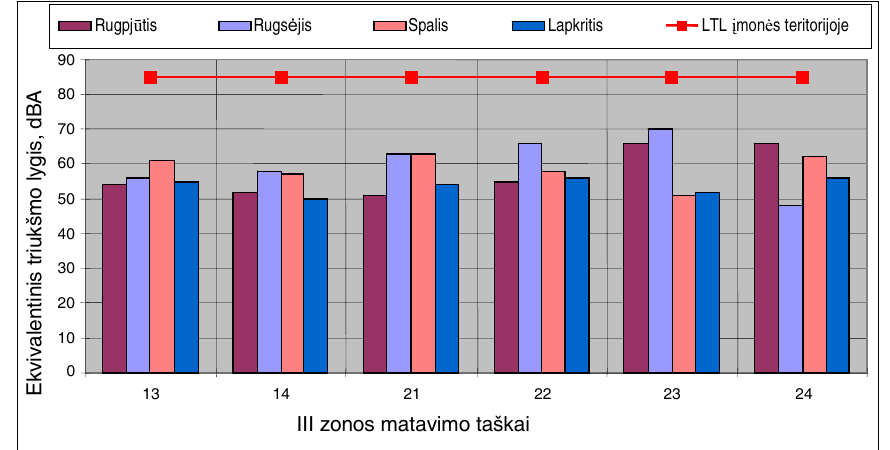
Fig 4. Measuring points of day-time reciprocal noise level on enterprise territory of zone